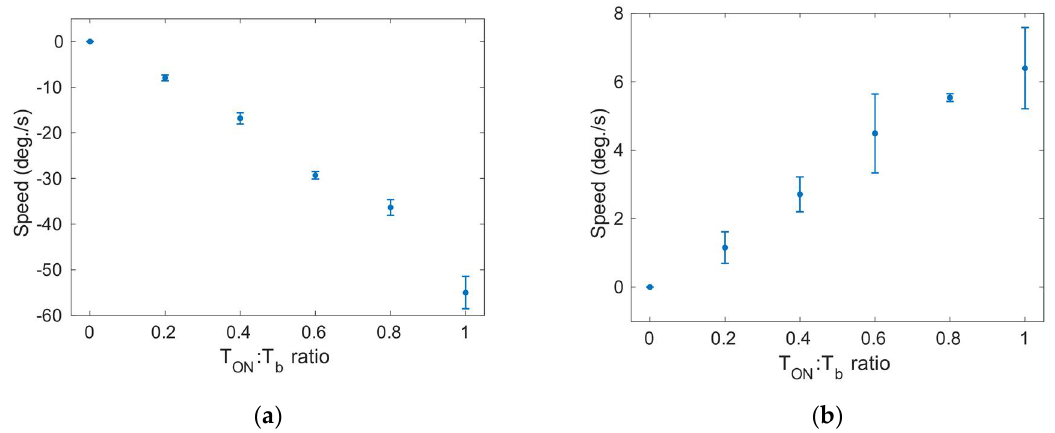
Figure 12. ( a ) Clockwise rotation speed as a function of T ON :T b ratio. ( b ) Counterclockwise rotation speed as a function of T ON :T b ratio. Symbols represent the average of 3 measurements.